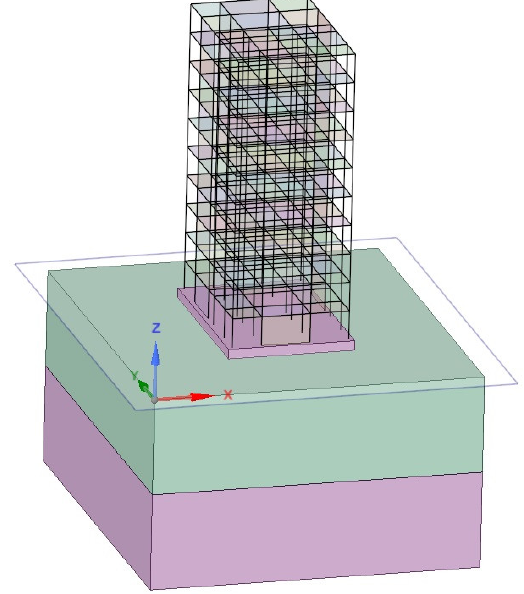
Figure 3. The geometry of the 10-story building.